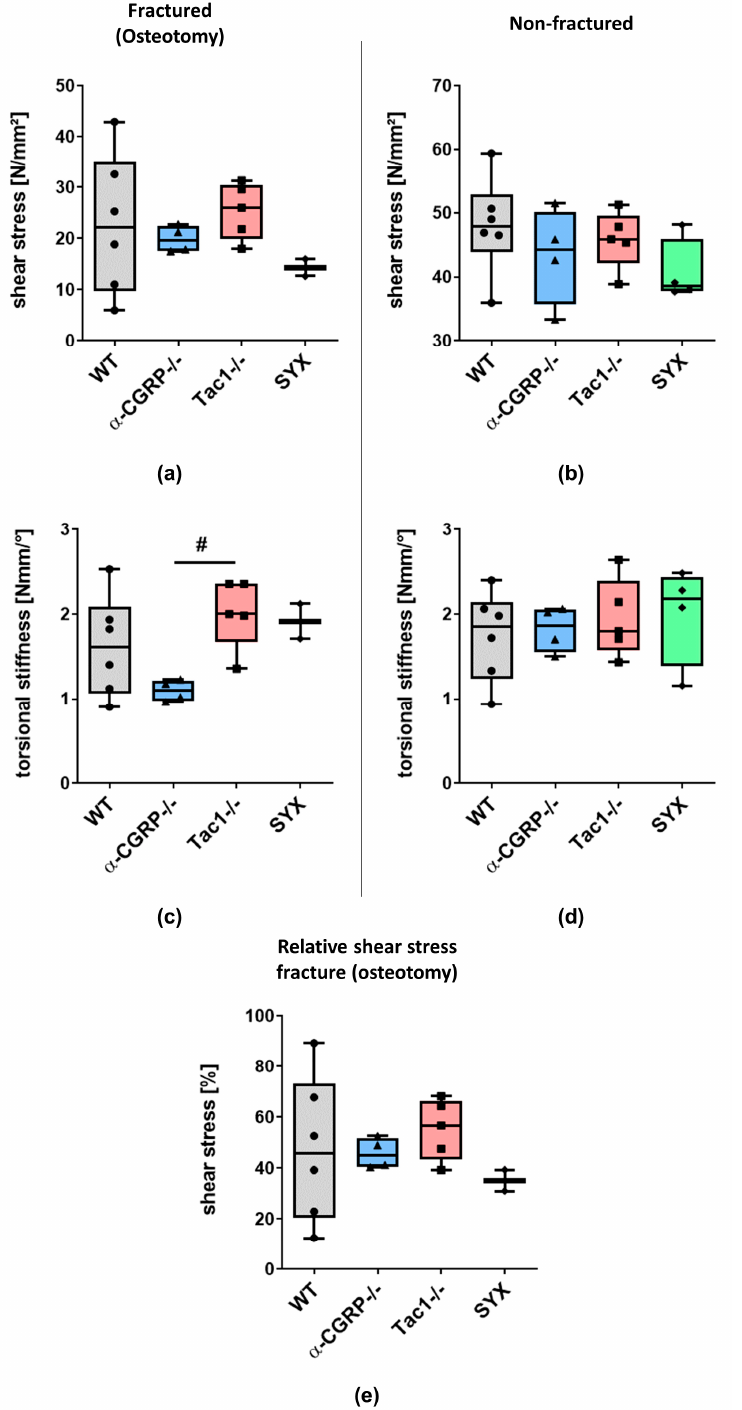
Figure 4. Biomechanical tests of fractured femora at 21 days after fracture and contralateral non-fractured femora from WT, α -CGRP − / − , Tac1 − / − and SYX mice. ( a , b ) Shear stress (N/mm 2 ) of fractured femora ( a ) and contralateral non-fractured femora ( b ). ( c , d ) Torsional stiffness (Nmm/ ◦ ) of fractured femora ( c ) and contralateral non- fractured femora ( d ). ( e ) Relative shear stress of fractured femora, calculated as percent- age of non-fractured femora (mean value of all non-fractured femora within one group). # over bars indicate differences between neurotransmitter-deficient groups. # = p ≤ 0.05. (nWT = 6, nCGRP − / − = 5, nTac1 − / − = 5, nSYX = 2 fractured, 4